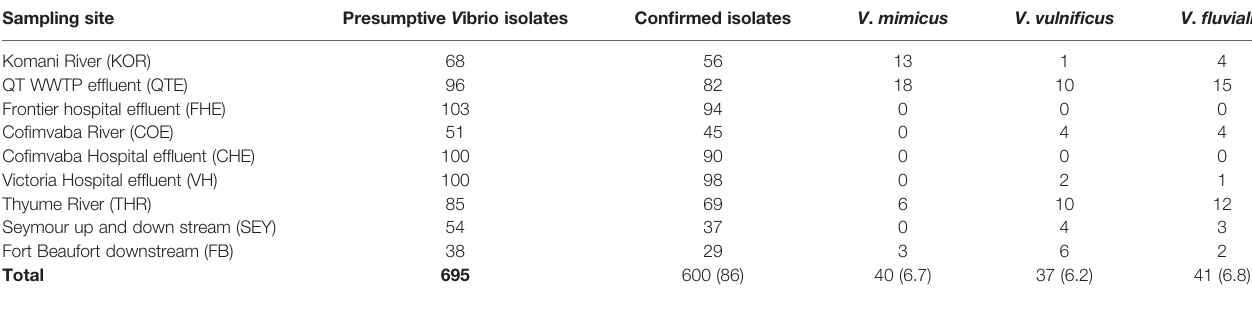
TABLE 2 | Con fi rmation and delineation of Vibrio species recovered from the different sampling sites. Sampling site